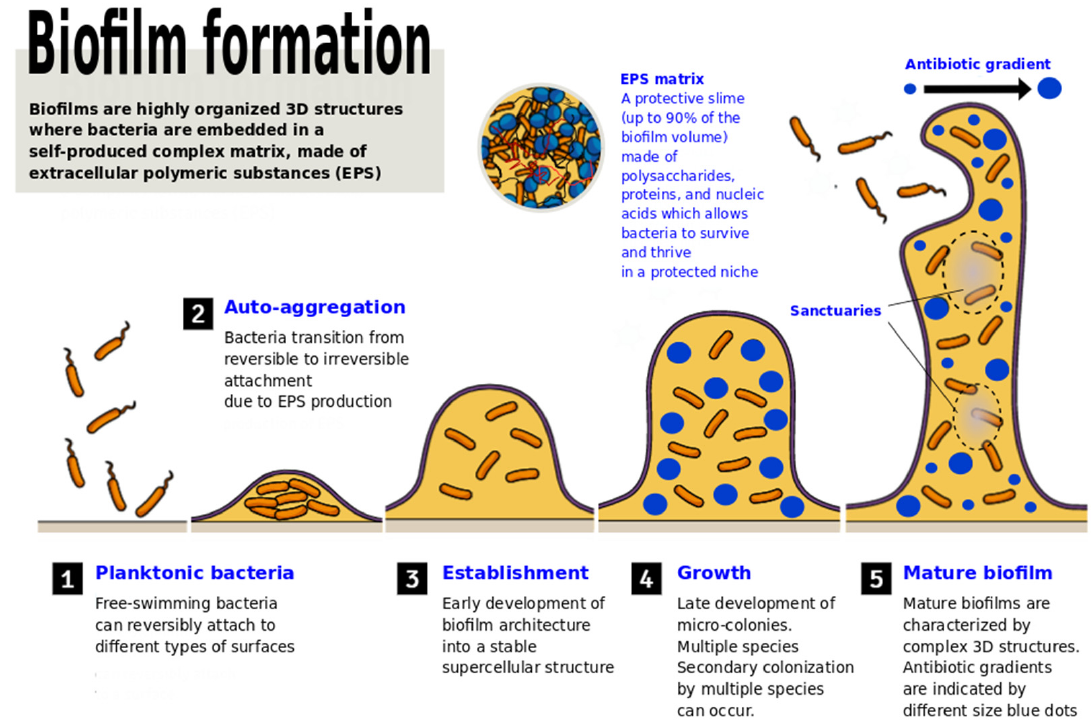
Figure 1. Schematic representation of the different steps required for the formation of a mature biofilm. The small and large blue dots represent areas with different antibiotic concentrations (denoting the presence of a gradient), and the grey zones are “sanctuaries” where bacteria can survive with a low concentration of antibiotics, which can favor the development of resistance.